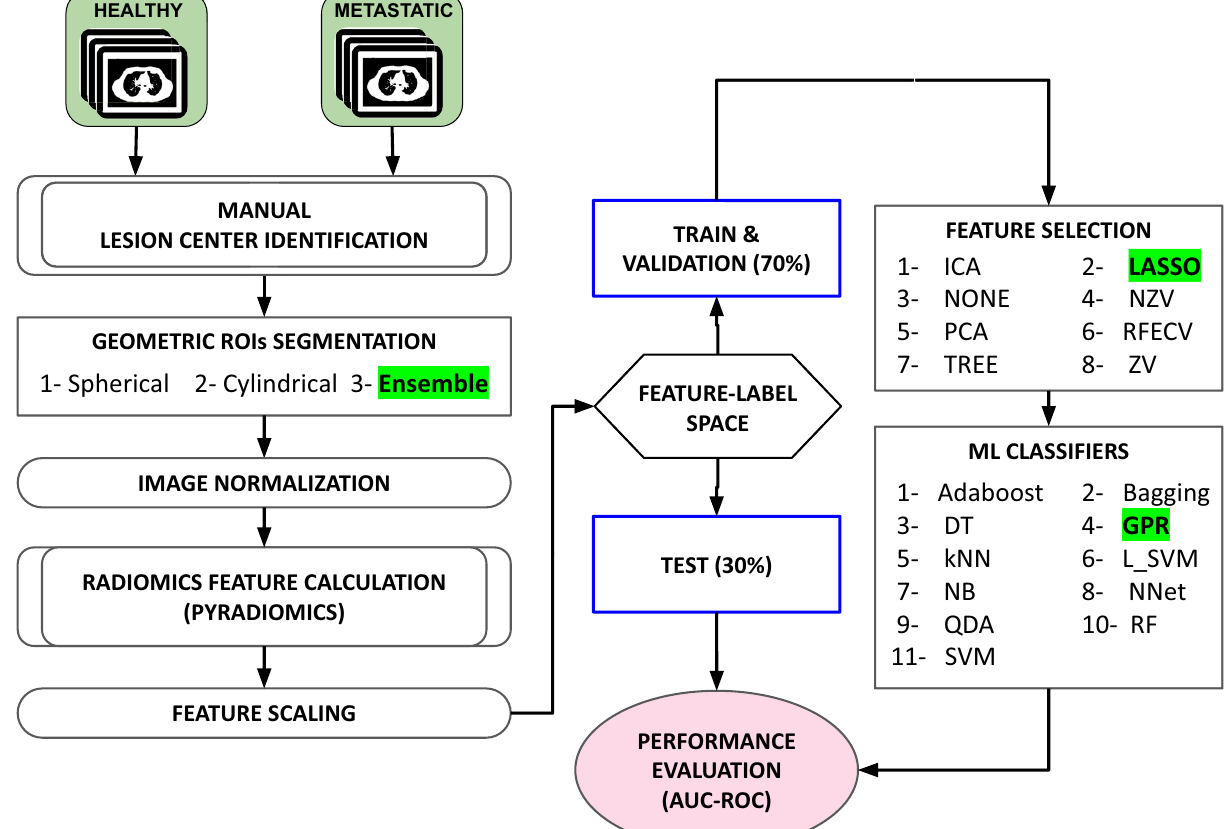
Figure 3. The exploration workflow for developing our radiomics-based ML models for classifying metastatic (BM) and healthy (HB) spinal bones. The best performing pipeline, as described in “Results”, is highlighted in